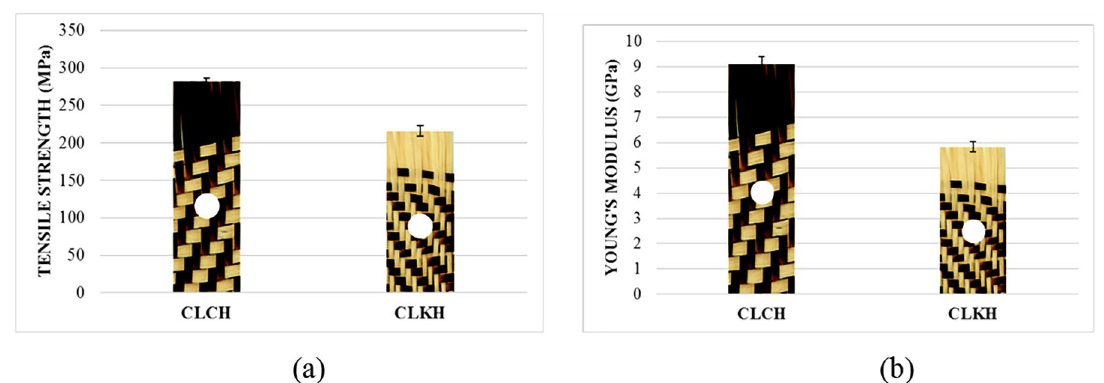
Figure 6. Comparative graph of the composite laminate ( CL) as a function of the simultaneous influence of anisotropy and a central hole. (a) Tensile strength. (b) Young’s modulus.